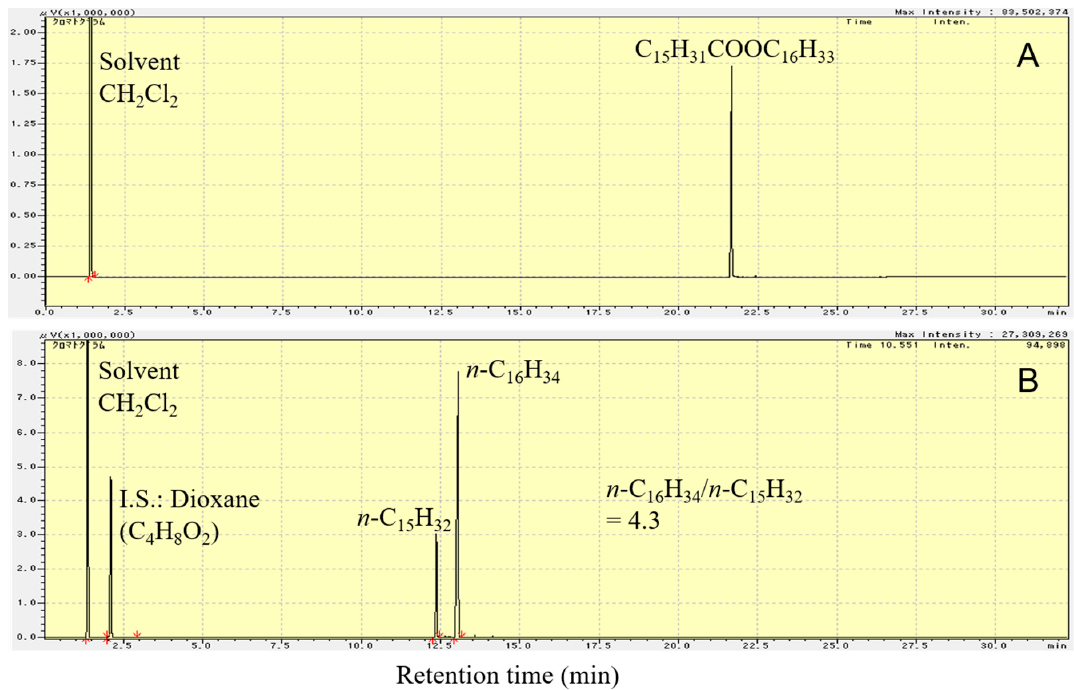
Figure 5. The flame ionization detector–gas chromatography (FID-GC) charts of C 15 H 31 COOC 16 H 33 ( A ) and the liquid product formed upon deoxygenation of C 15 H 31 COOC 16 H 33 in H 2 atmosphere, at 300 °C, for 2 h, over 1 wt.% Pd/Mg(Al)O catalyst ( B ). Reaction conditions: C 15 H 31 COOC 16 H 33 : 5 g; catalyst: 0.2 g; and, H 2 pressure at 25 °C: 0.9 MPa.